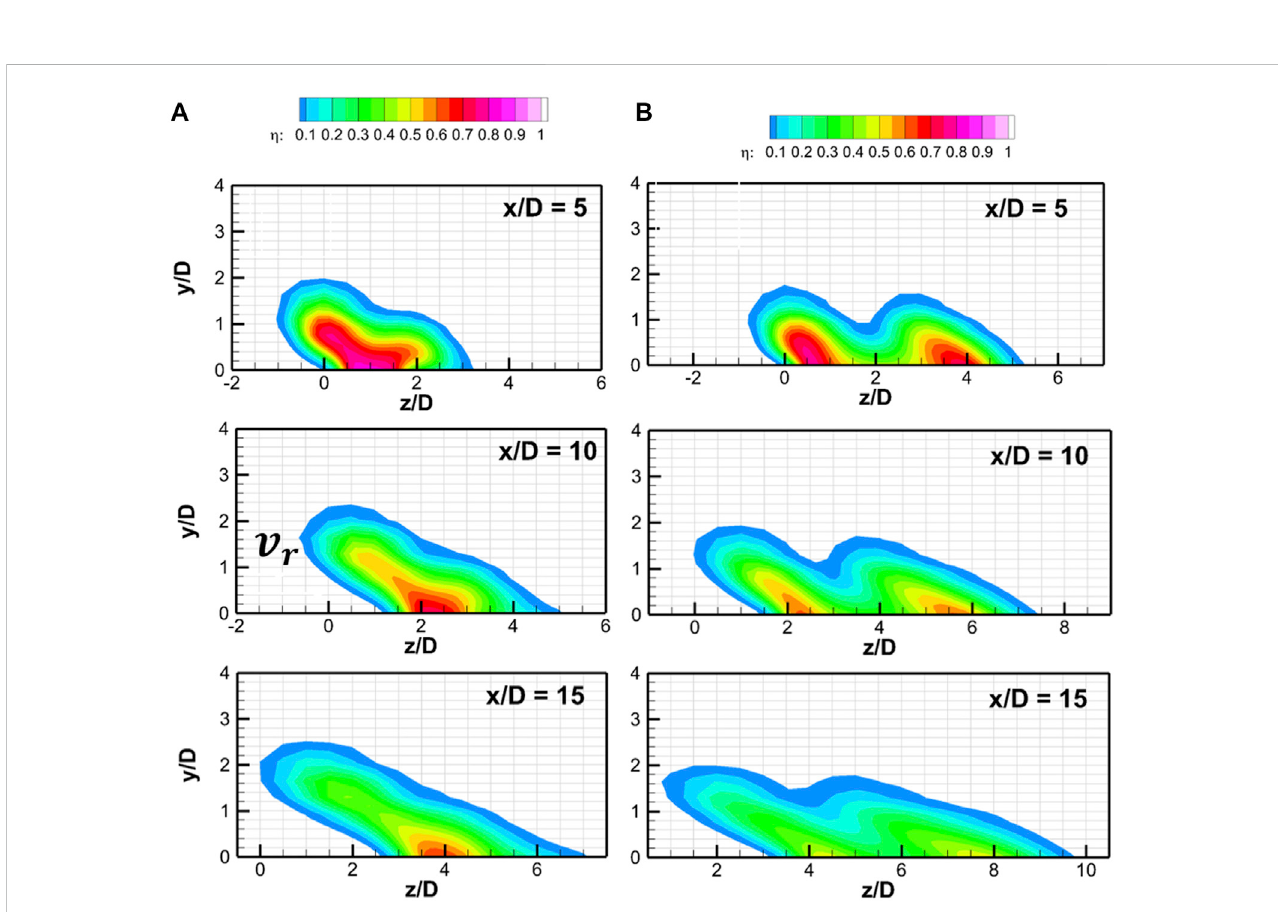
FIGURE 10 Comparison of spatial coolant distribution at x / D = 5, 10, and 15: (A) baseline hole and (B) optimized hole.